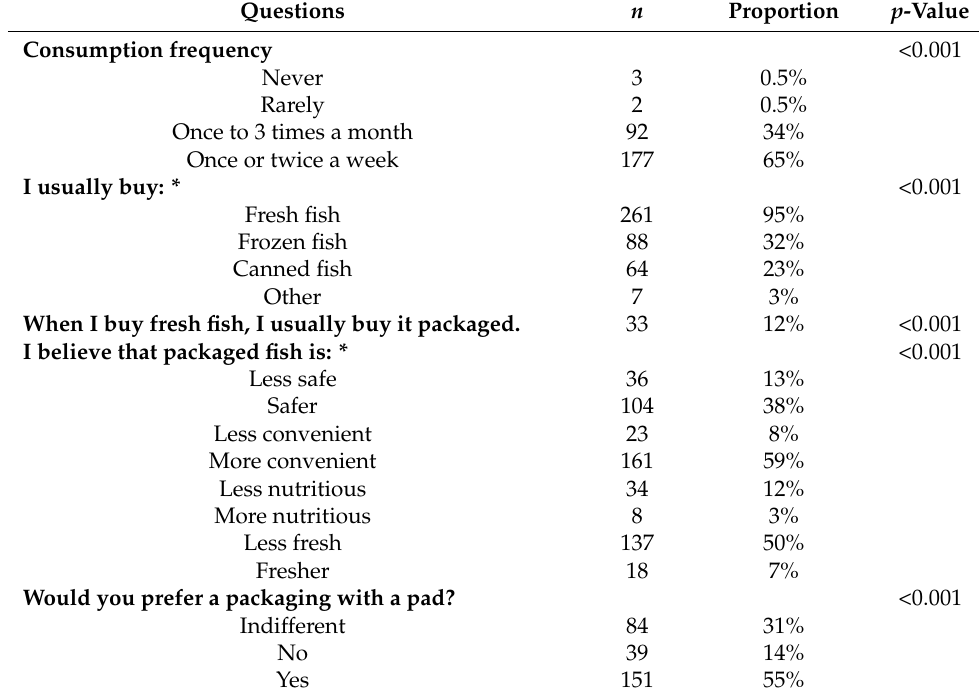
Table 2. Consumption frequency and attitudes towards fish and fish packaging. Results are presented as frequencies ( n ) and proportion (%) out of 274 consumers in total. P -values were calculated by applying the chi-square test at a =